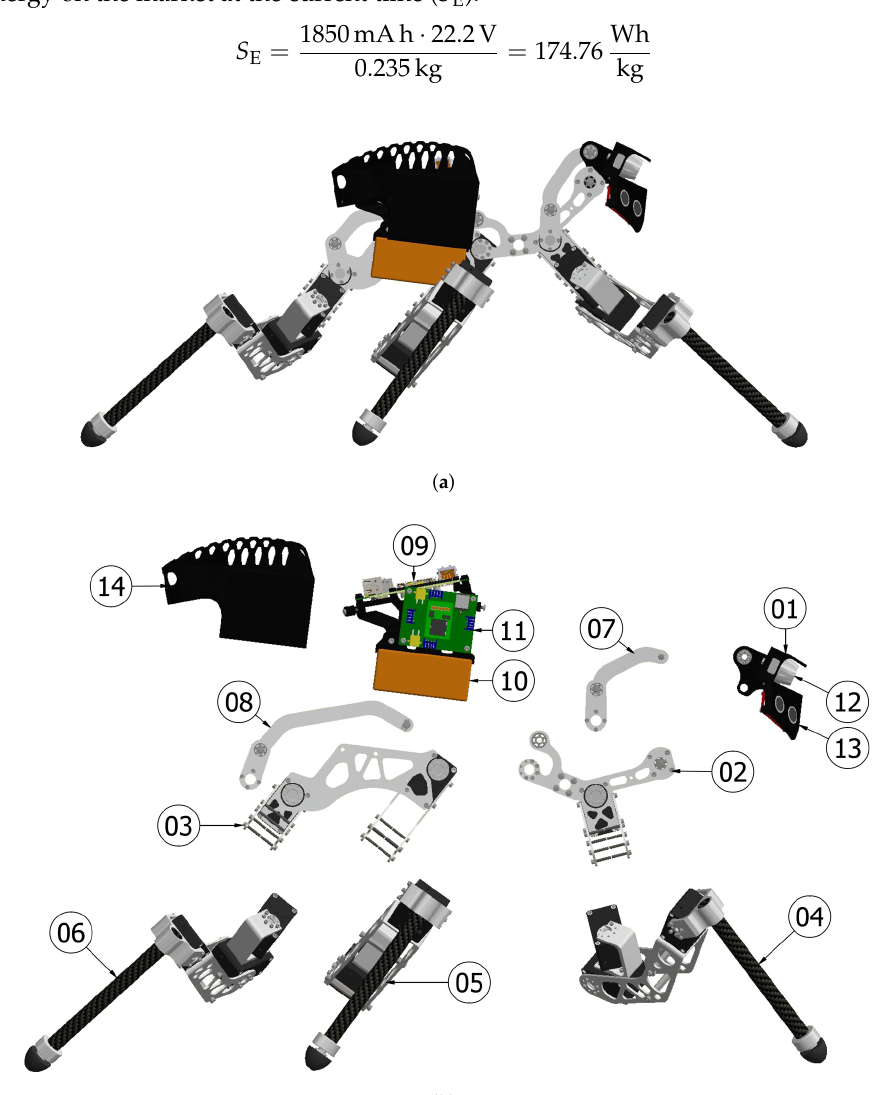
Figure 6. A rendered assembled view of ALPHA ( a ) and exploded view of ALPHA components ( b ): 01 head, 02 thorax, 03 abdomen, 04 front leg, 05 middle leg, 06 hind leg, 07 push rod for actuating the HA joint, 08 push rod for actuating the TA joint, 09 controller, 10 batteries, 11 power board, 12 Intel D435, 13 ultrasonic sensor, 14 protective